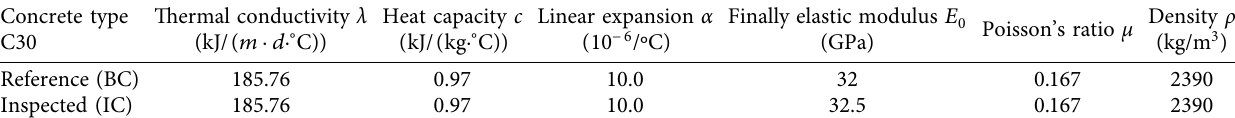
Table 4: Thermodynamic parameters of